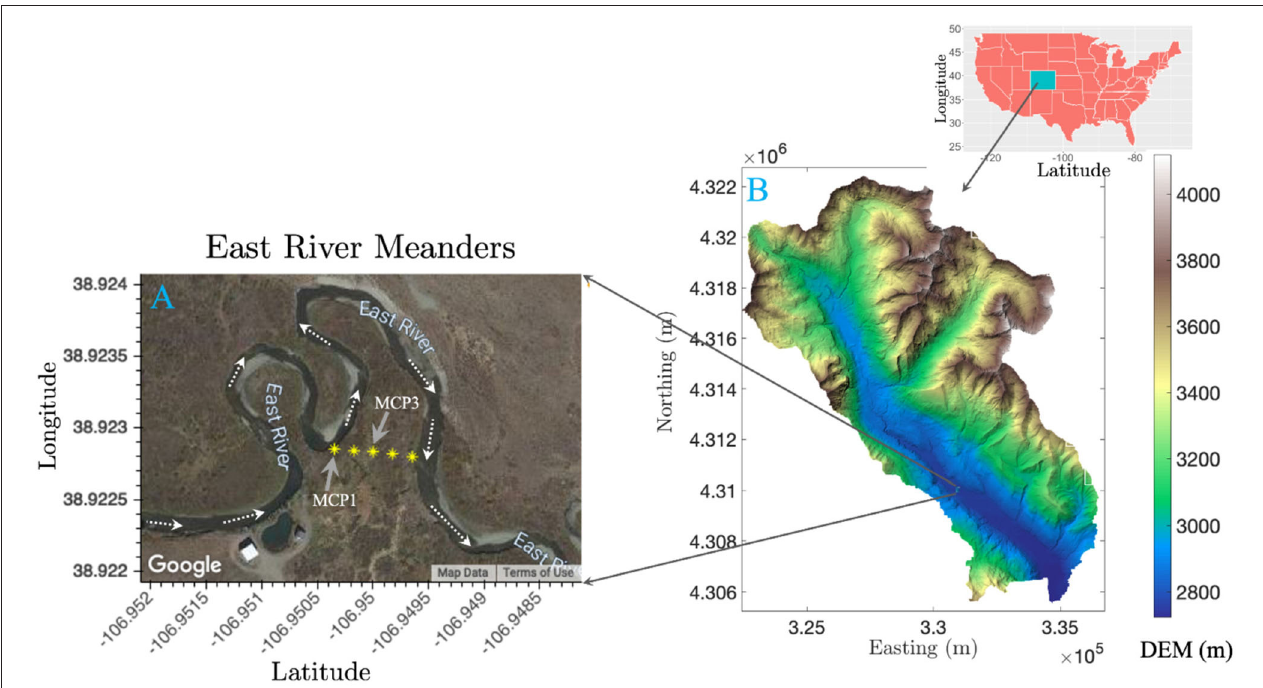
FIGURE 1 | Map showing core sampling locations of MCP1 and MCP3 from the meander C floodplain transect (A) , and a digital elevation map (DEM) of the East River watershed in Colorado (B)